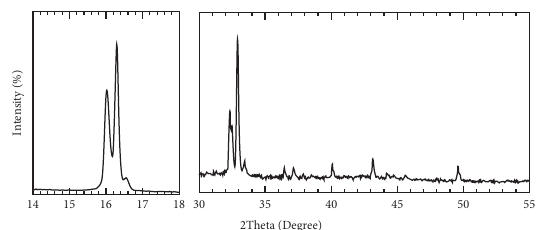
Figure 6: XRD patterns of the P2/P3-NaNMC electrode discharge to